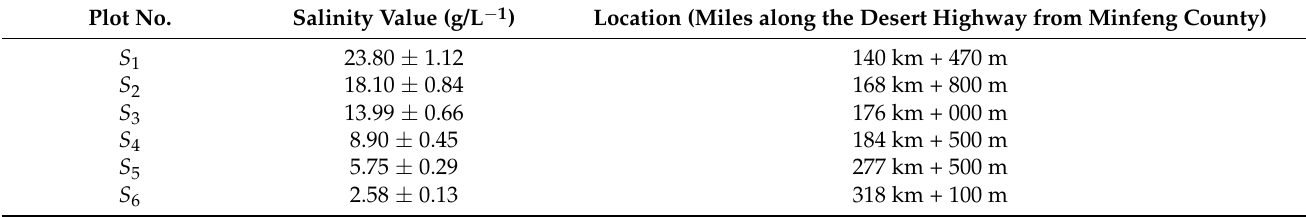
Table 1. Details of the sampling plots receiving irrigation water at different levels of salinity (mean ± SD, n = 10). Data were mean ± standard deviation (n = 10). Plot No. Salinity Value (g/L − 1